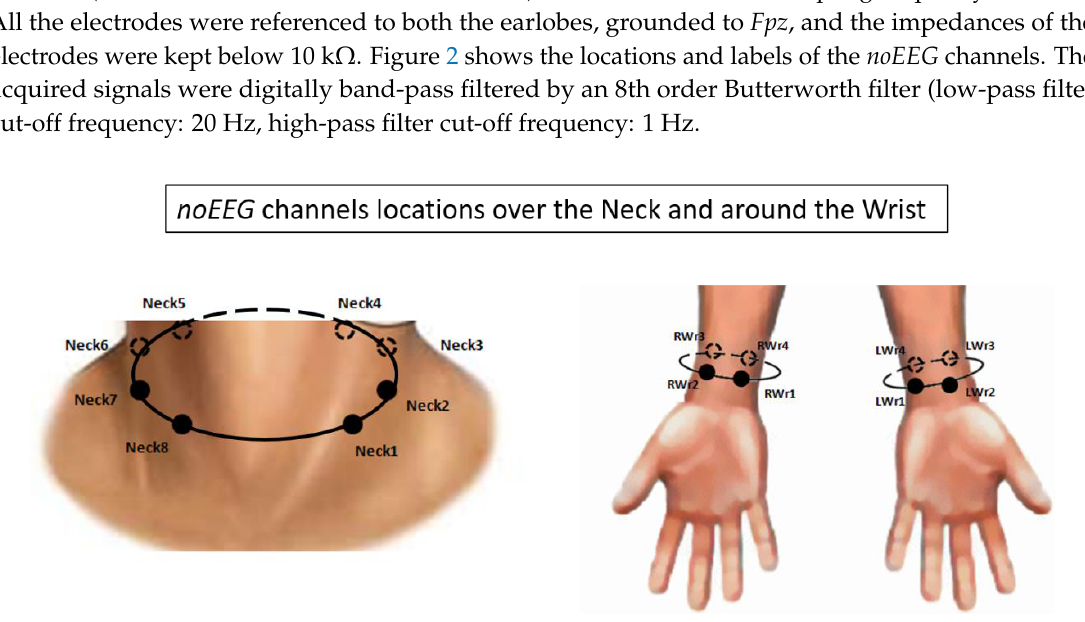
Figure 2. Schematic representation of the non-cerebral ( noEEG ) channels locations and labels over the neck and wrists.